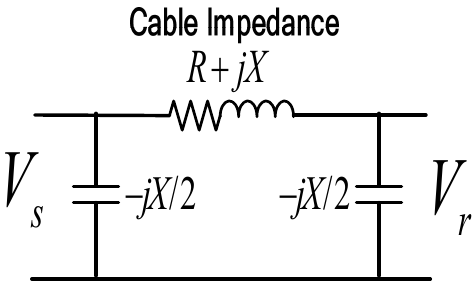
Figure 1. Modeling of short and medium-length submarine cables.